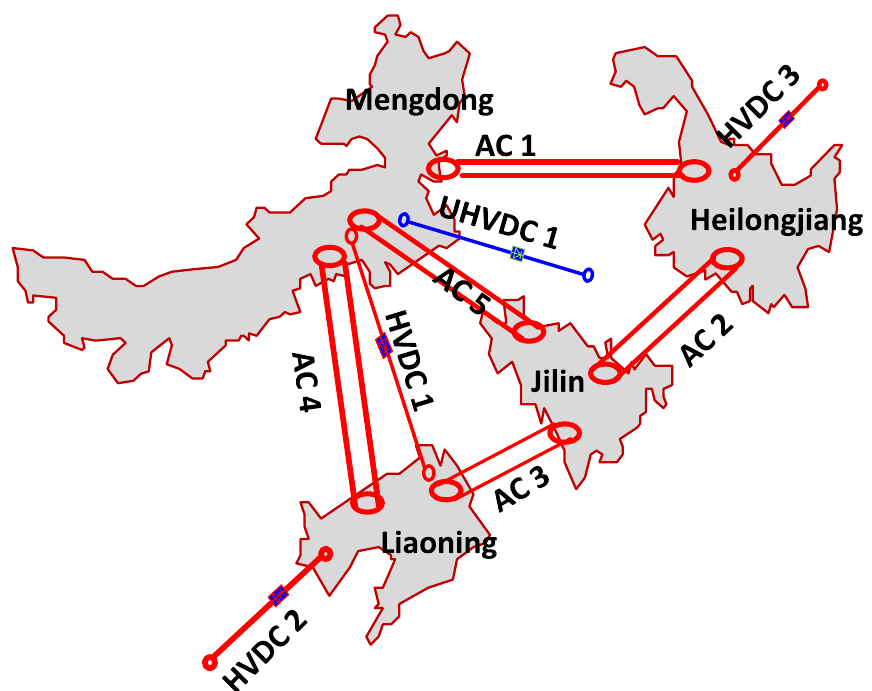
Fig. 4 Tie-lines map of Northeast region of